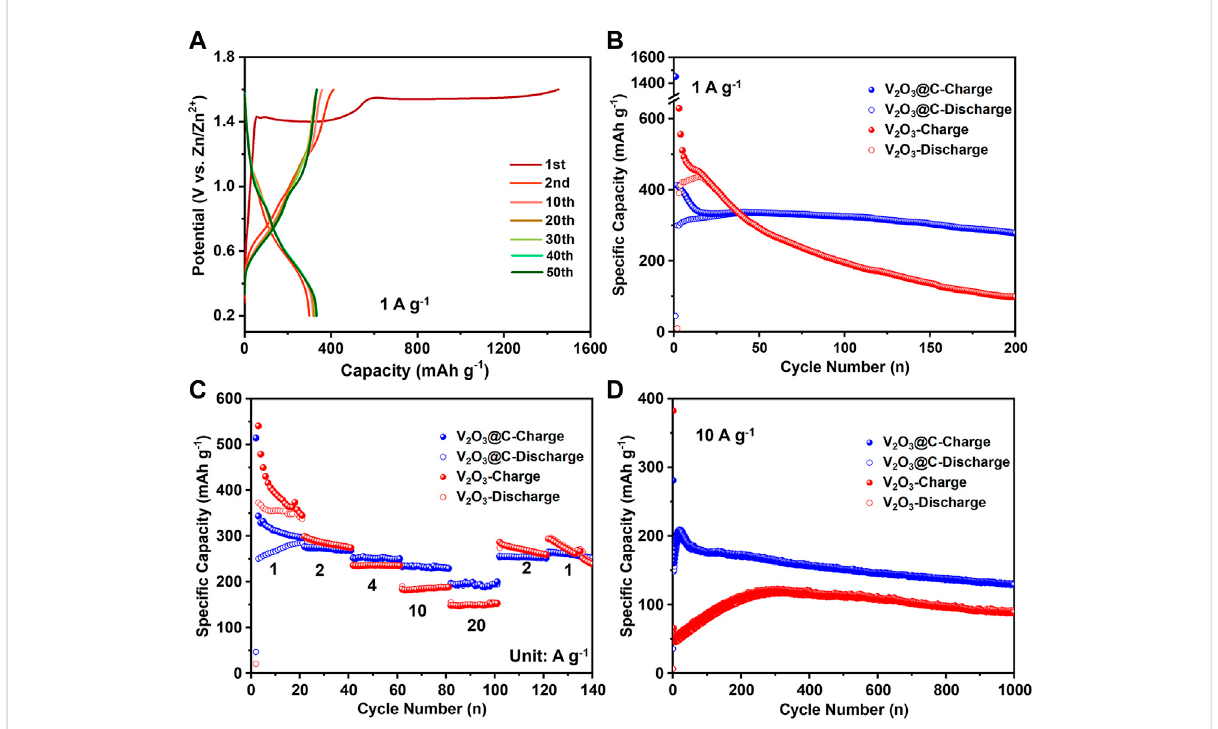
FIGURE 3 (A) Discharge/charge curves represent cycles at 1 A g − 1 for the V rate (1 A g − 1 ), (C) rate performance, and (D) cycling performance at a high rate (10 A g − 1 ) for V 2 O 3 and V 2 O 3 @C cathodes in aqueous ZnSO 4